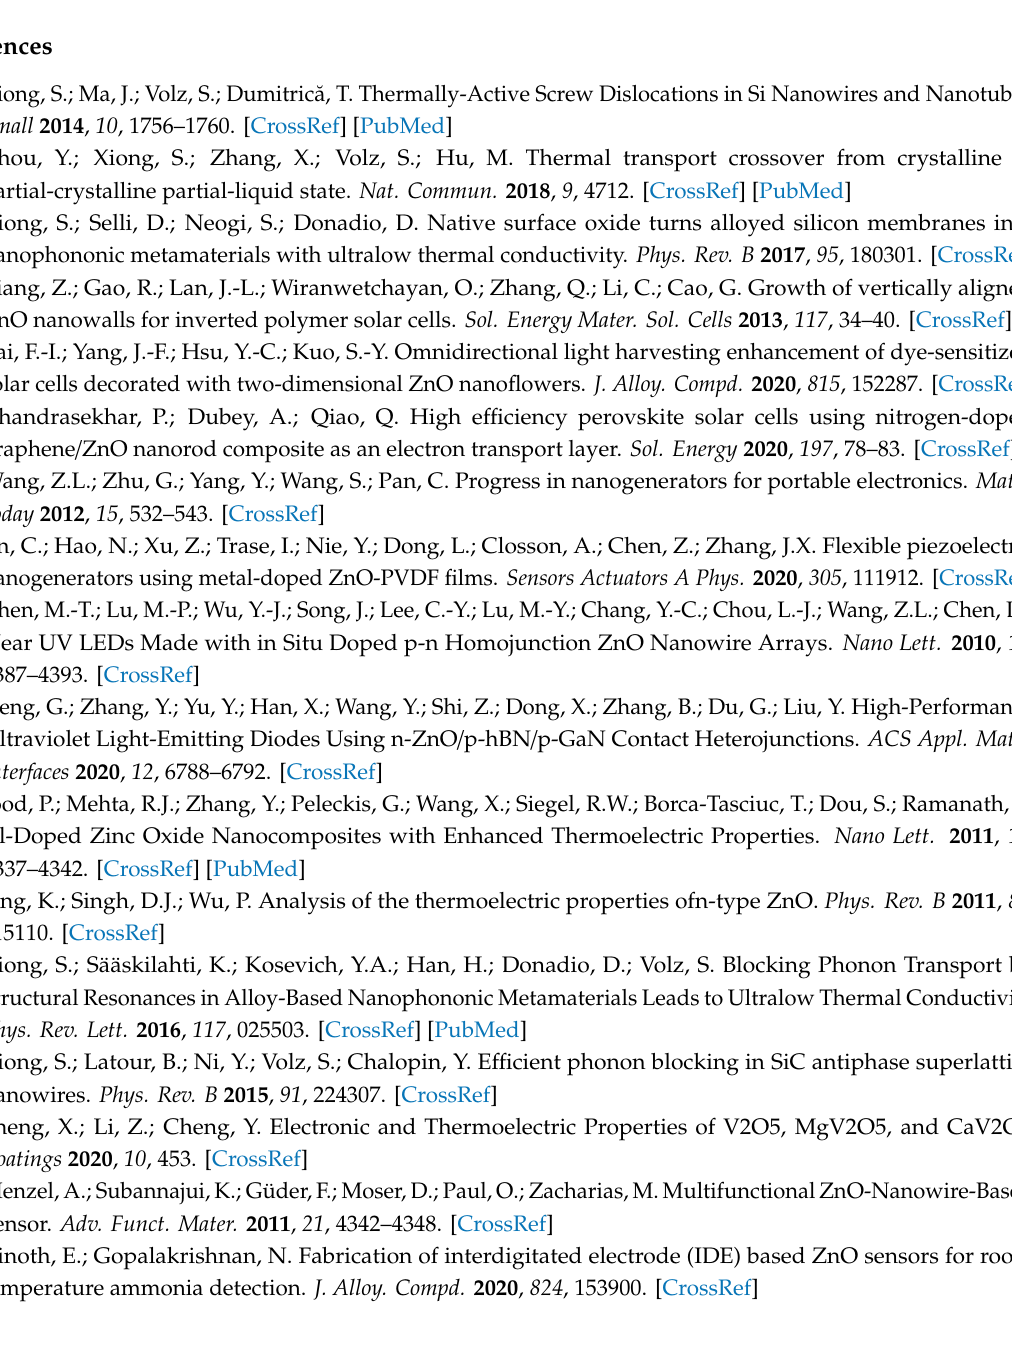
Figure S1: The SEM image of obtained ZnO rods in the edge of the samples. Figure S2: The enlarged cross-sectional images of the obtained ZnO rod arrays, corresponding to Figure 8 in the manuscript. All authors have read